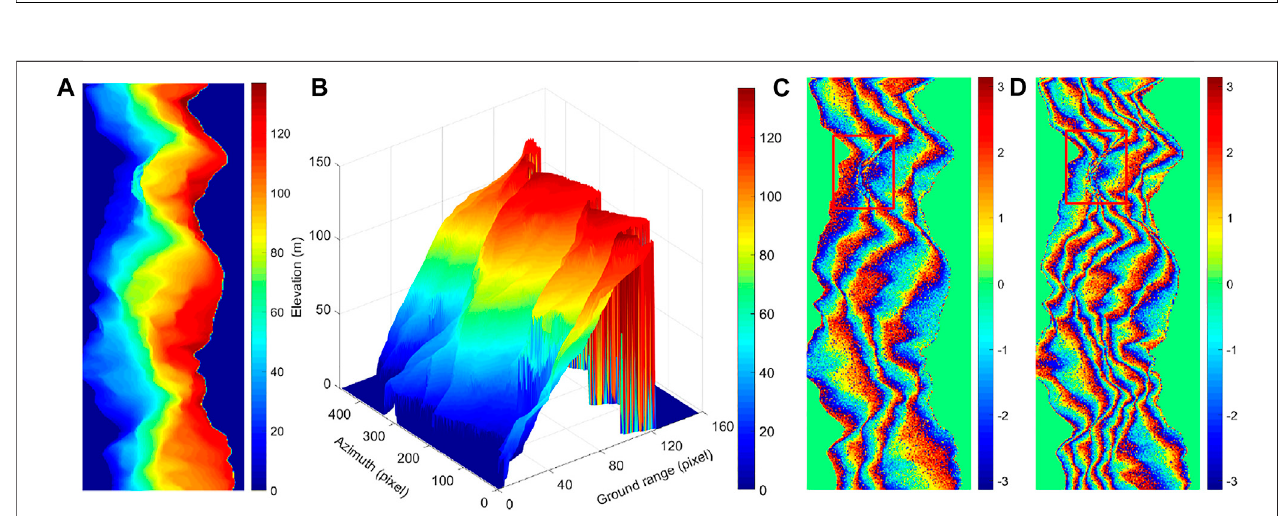
FIGURE 12 | Isolation Peak National Park, United States (A) 2D DEM (m). (B) 3D DEM (m). (C) Simulated interferogram with 105 m baseline (rad). (D) Simulated interferogram with 189 m baseline (rad).